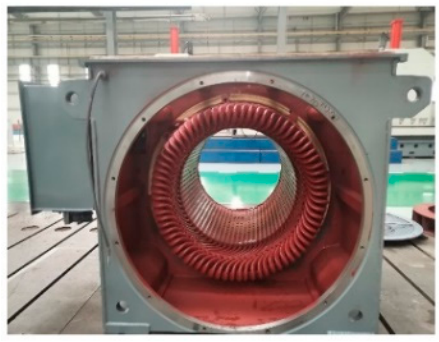
Figure 21. Stator structure.